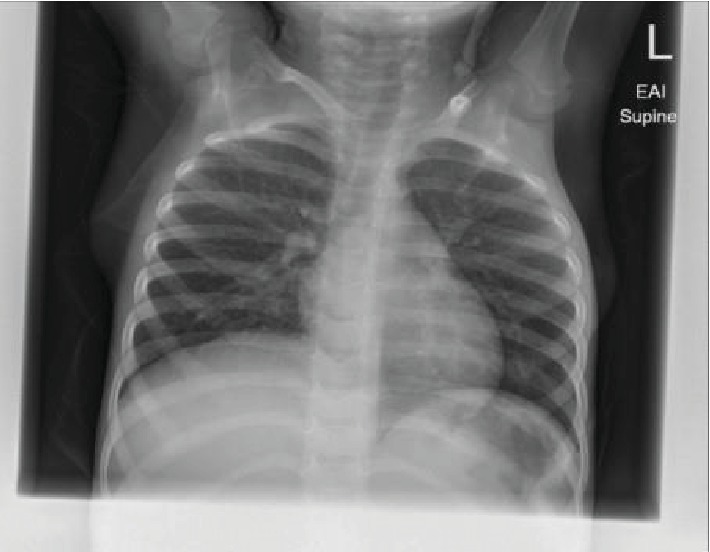
Chest X-ray showing an abdominal mass.